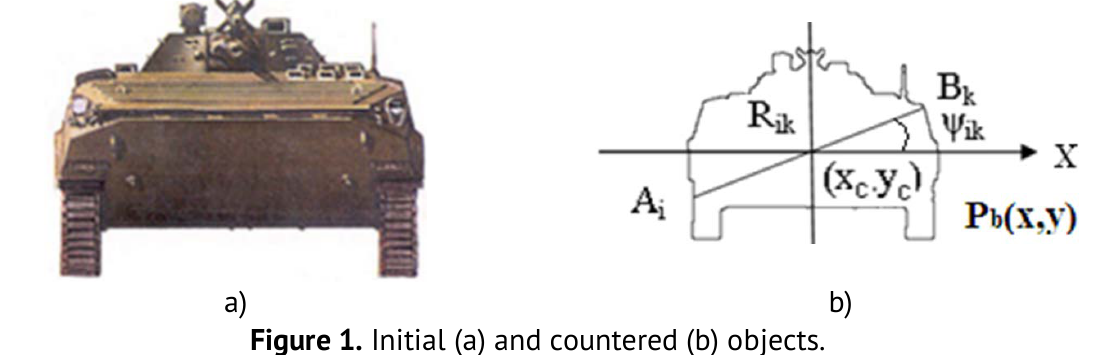
Figure 1. Initial (a) and countered (b)